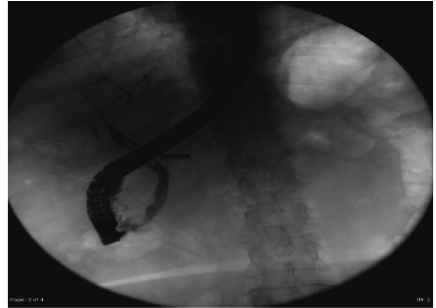
Figure 6: Post-op ERCP demonstrating resolution of Mirizzi syndrome and no cystic duct stump leak. Balloon sweep (black arrow) of common bile duct was performed after stent removal and it revealed no common bile duct